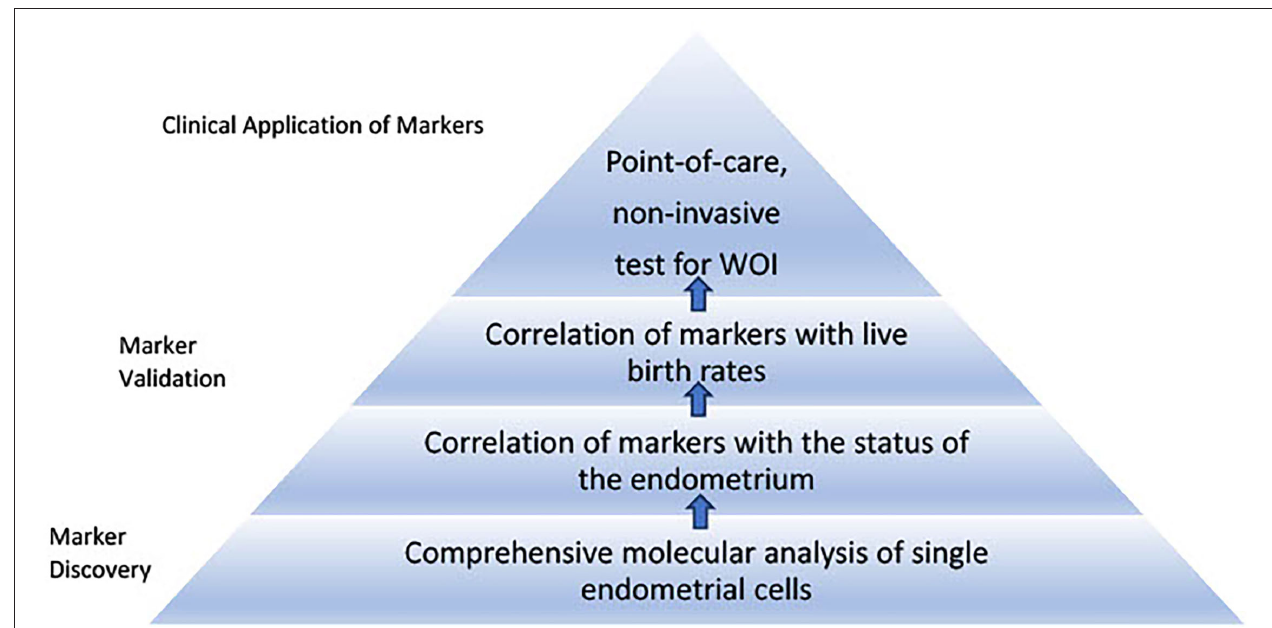
FIGURE 3 | Roadmap to develop proposed tests for the window of implantation. The first stage of the roadmap involves marker discovery through comprehensive single-cell molecular analysis of the endometrial cells. Markers specific to each endometrial cell type associated with histological findings of receptivity and live birth can be validated and thresholds of the markers can be established through large-scale clinical studies. The second stage involves development of point-of-care, non-invasive tests for the window of implantation. This stage requires selection of essential markers from different sources such as blood and urine tests to be integrated into routine clinical